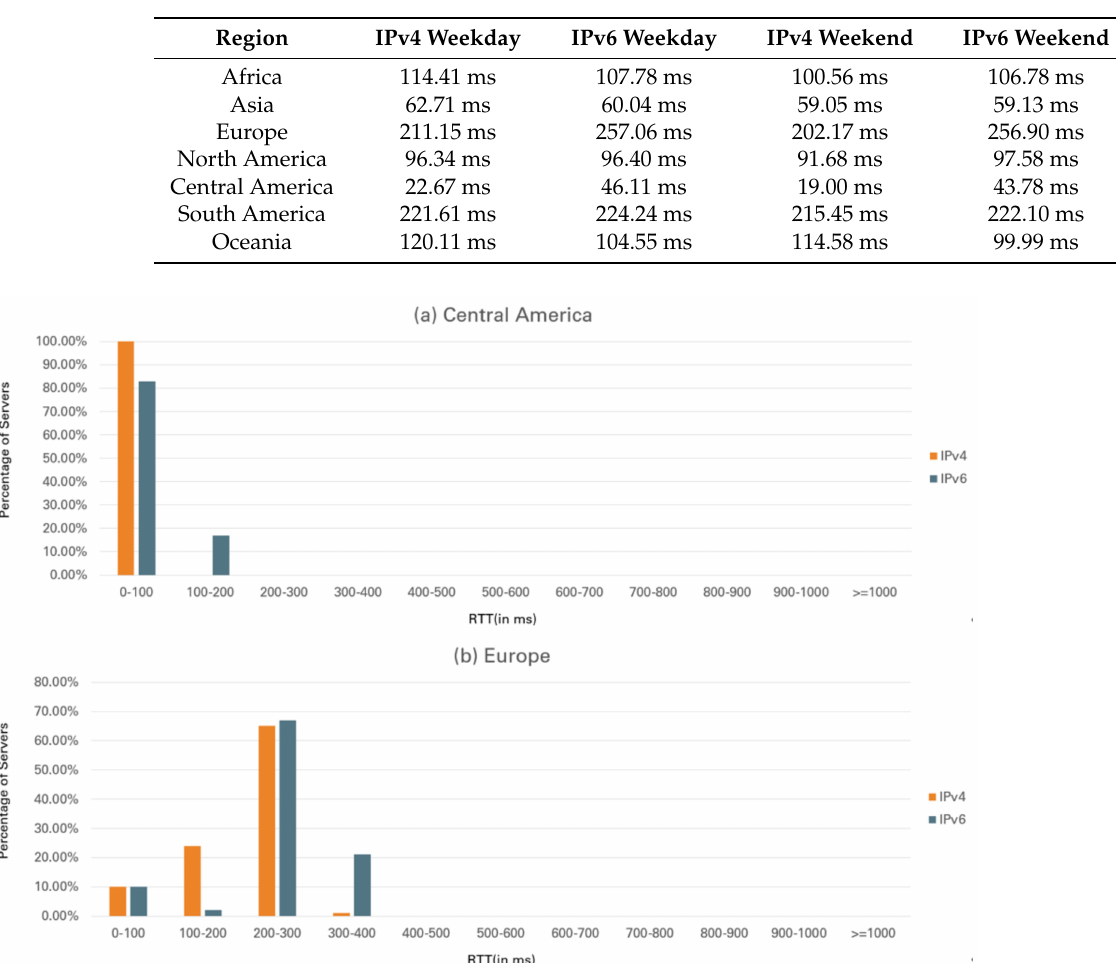
Table 7. Breakdown of RTT by region.